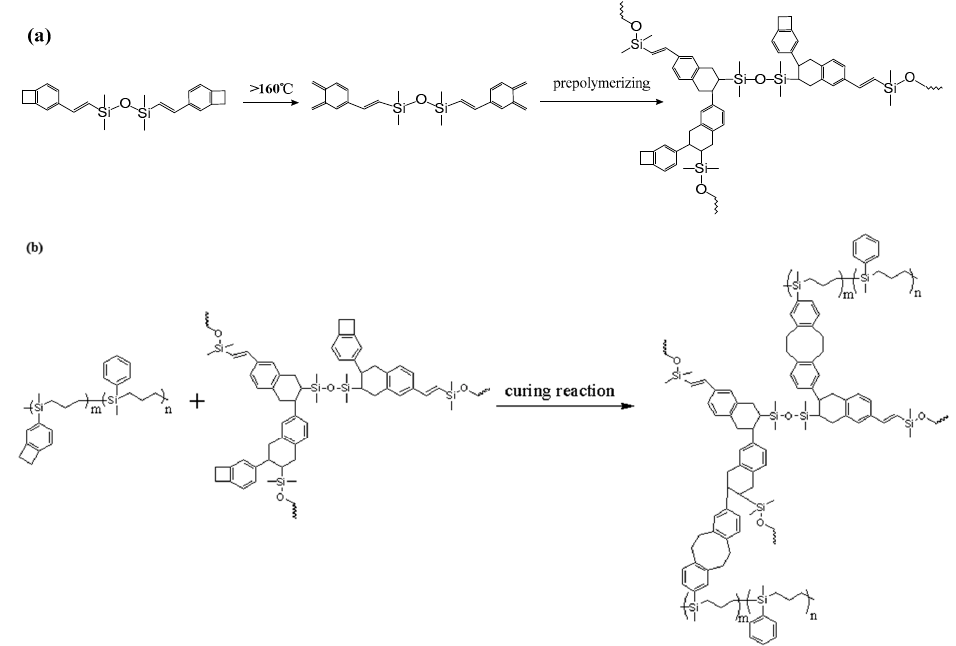
Scheme 3. Schematic diagram of ( a ) synthesis of DVS-BCB prepolymer and ( b ) thermal curing mechanism of P(4-MB-co- 1-MP)/DVS-BCB.